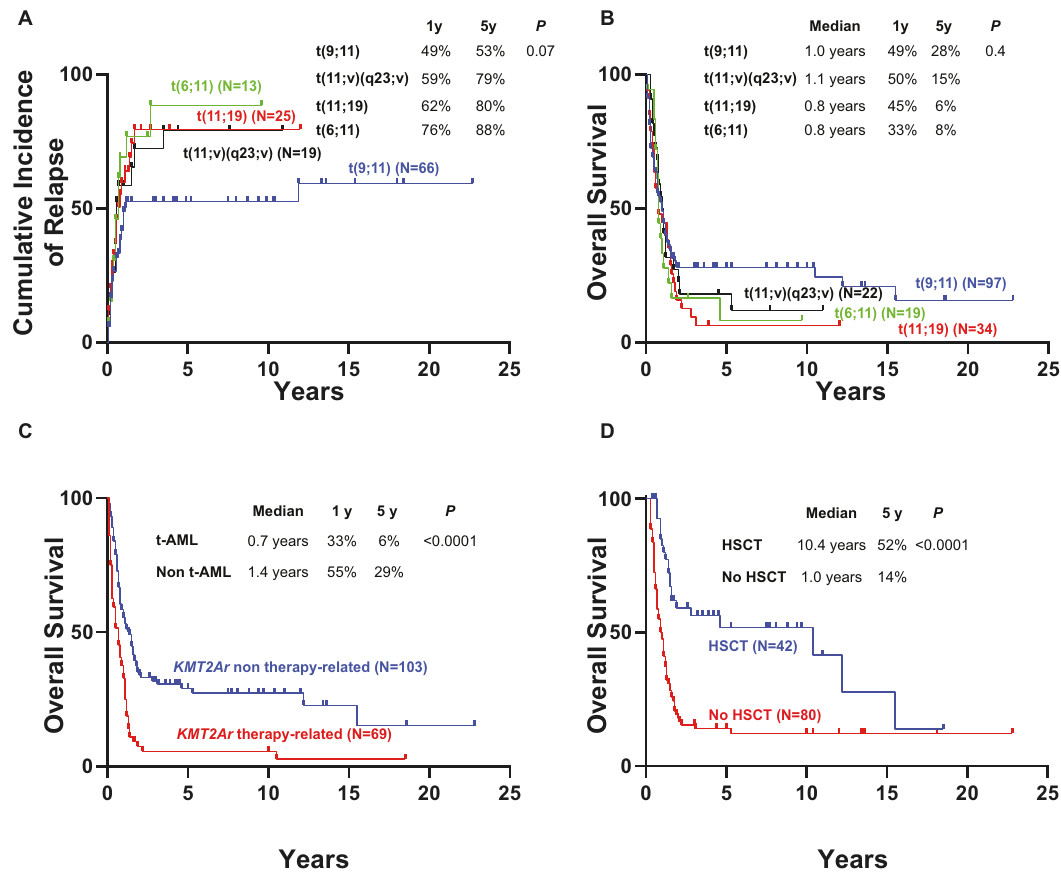
Fig. 4 Risk of relapse and overall survival in newly diagnosed KMT2Ar AML. A Cumulative incidence of relapse by subtype of KMT2Ar . B Overall survival by subtype of KMT2Ar . C Overall survival of newly diagnosed KMT2Ar AML by therapy-related status . D Landmark analysis comparing overall survival of patients with newly diagnosed KMT2Ar AML who underwent an allogeneic hematopoietic stem cell transplant following the fi rst remission to those who did not undergo